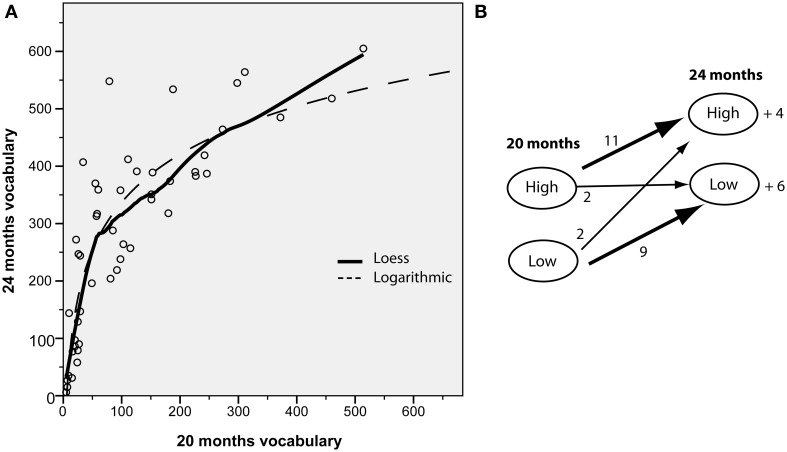
(A) Relation between productive vocabularies measured by the SECDI at 20 and 24 months. The dotted line represents a logarithmic fitted line, and the connected line represents a loess fit. (B) Illustration of participants from the ERP samples included in the high vs. low vocabulary groups at the two time points. The number by the arrow represents the number of participants from the 20 month groups that were included in each group at 24 months. Note that 24 participants from the 20 month sample provided ERP data at 24 months, and 10 “novel” participants entered the 24 month groups.